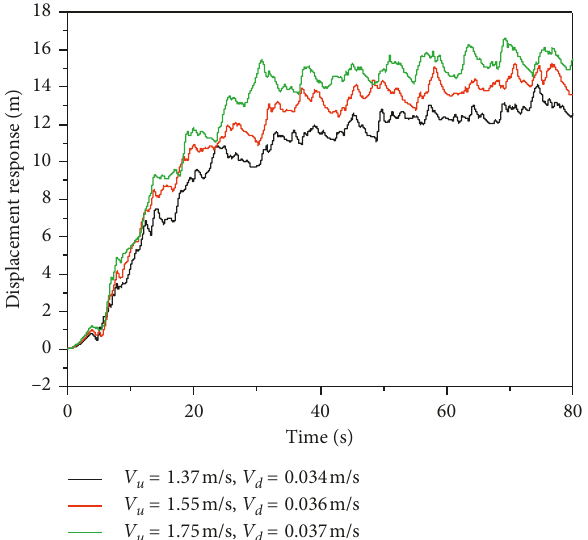
Figure 13: Effect of shear velocity on maximum axial compressive force. Figure 11: Effect of shear velocity on transverse